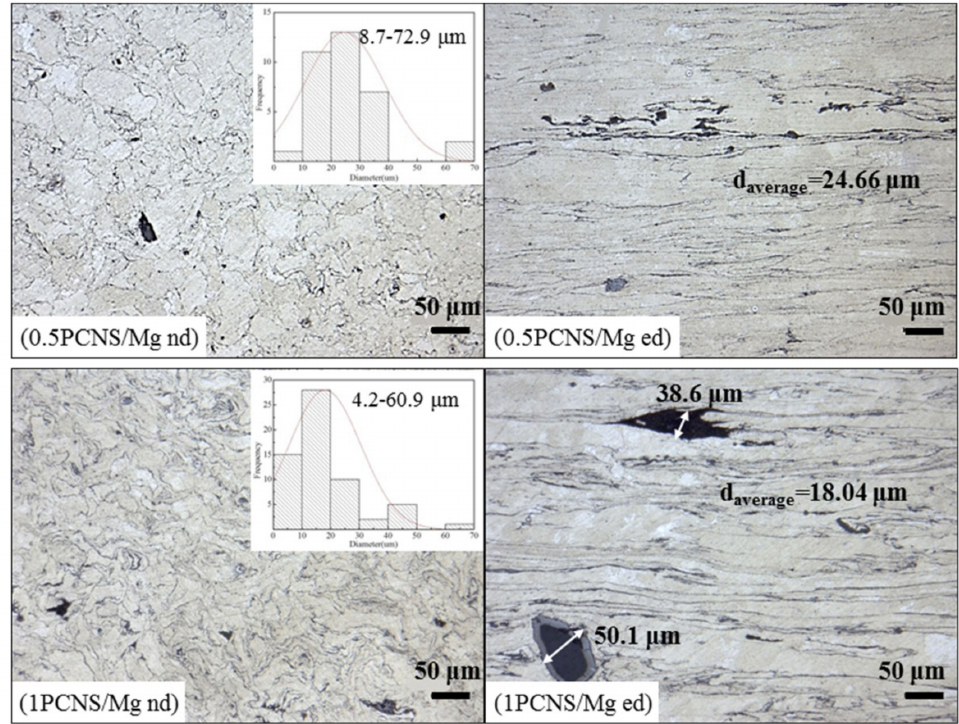
Figure 8. Optical micrographs of xPCNS / Mg bulk composites with the content of PCNS is 0.5 and 1